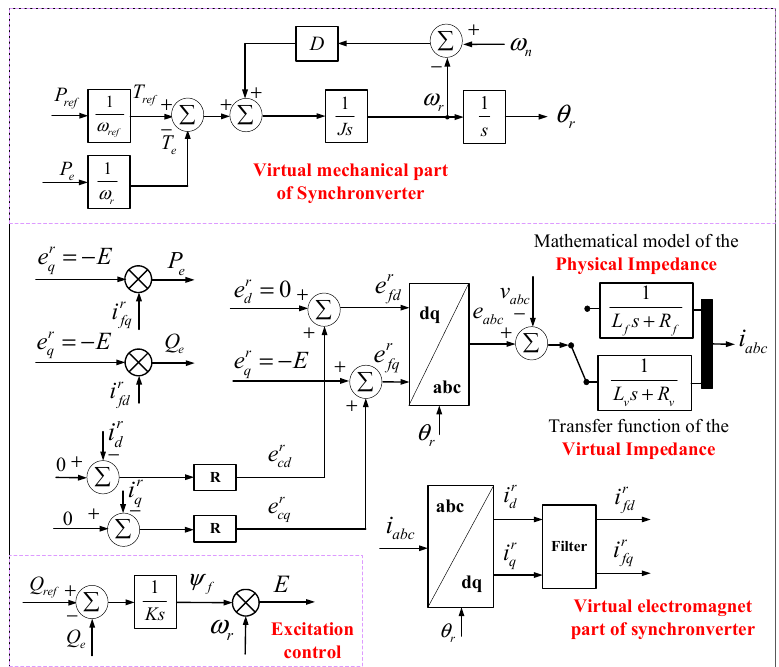
Figure 6. Control diagram of the proposed self-synchronized synchronverter in unbalanced power grid.